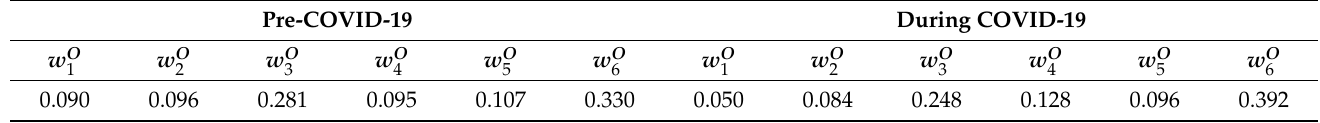
Table 8. The objective weights of bank efficiency criteria pre-and during